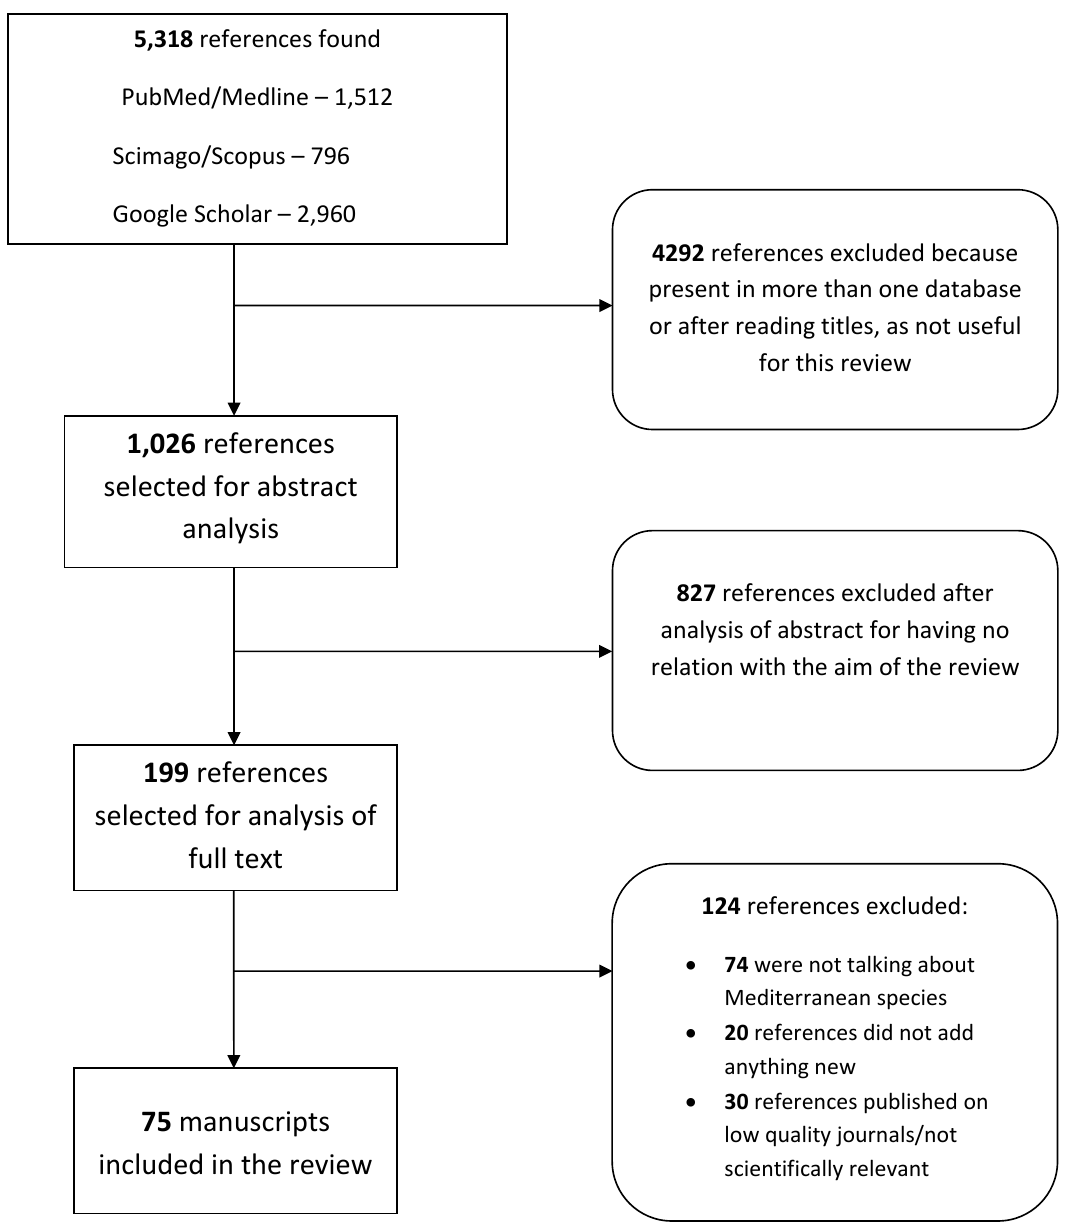
Figure 1. Article selection flow